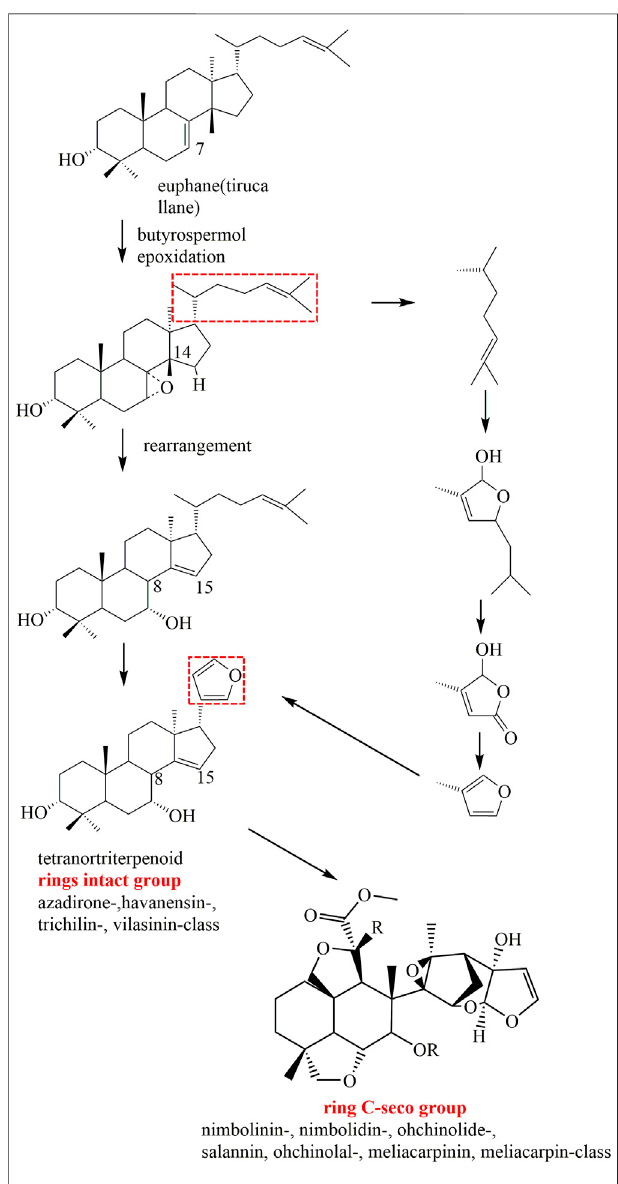
FIGURE 1 | Proposed major biosynthesis pathways of limonoids in genus Melia